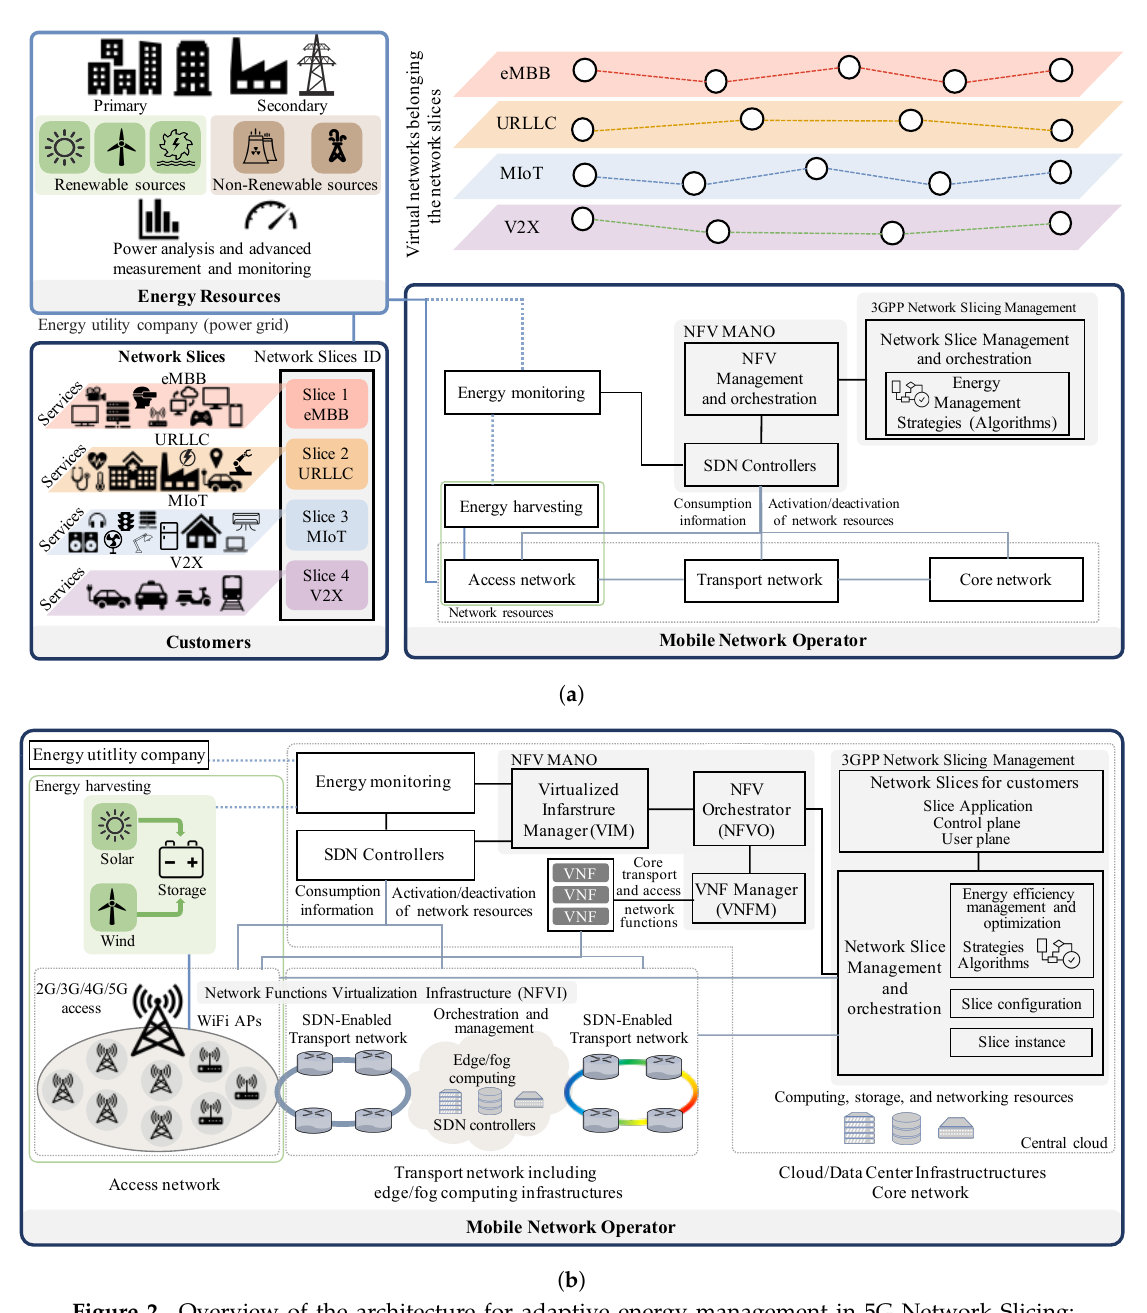
Figure 2. Overview of the architecture for adaptive energy management in 5G Network Slicing: ( a ) schematic of the proposed architecture; and ( b ) schematic of the network operator and management